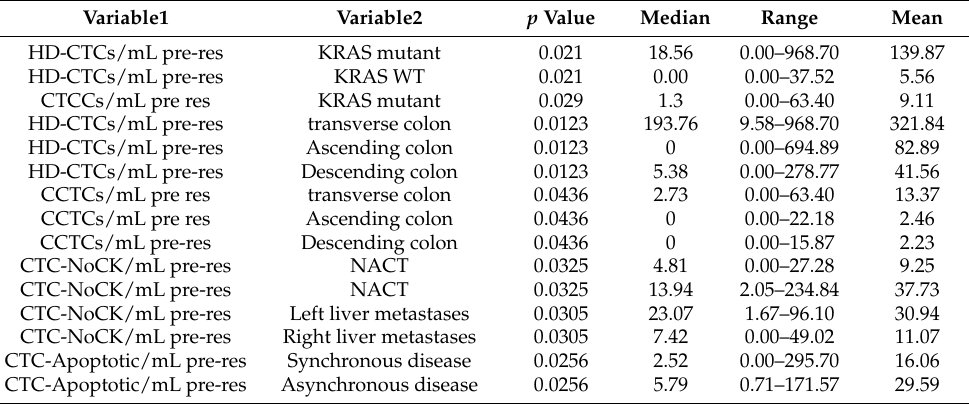
Table 2. HDSCA data correlates with clinical metrics. NACT: neoadjuvant chemotherapy; KRAS WT: KRAS wild